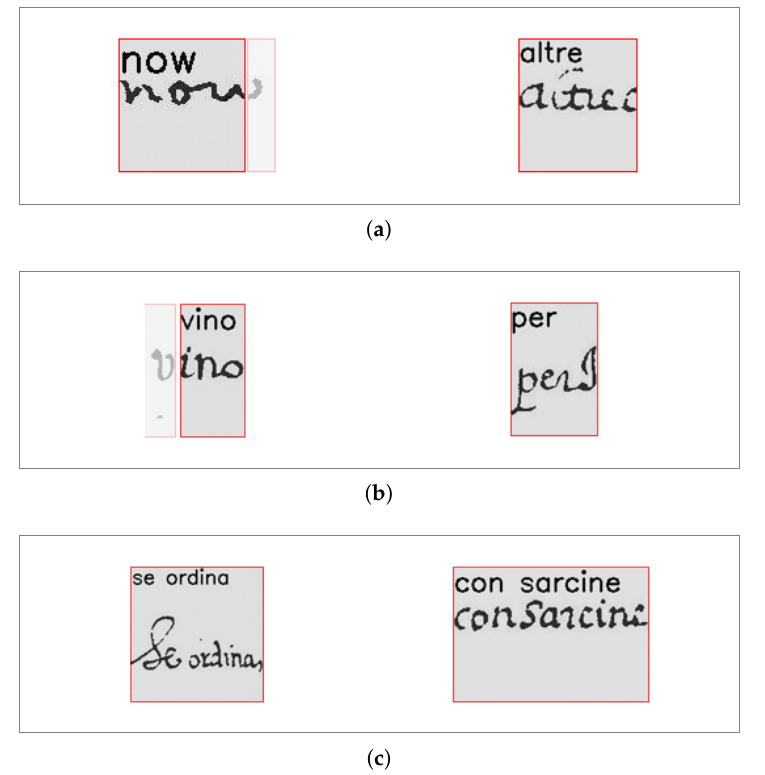
Figure 10. Examples of acceptable alignments: ( a ) missing/added strokes; ( b ) missing/added characters; ( c ) multiple-to-one